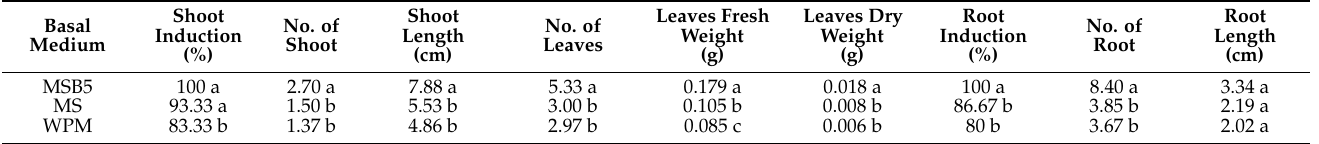
Table 1. Shoot induction of C. caesia as affected by different formulations of basal